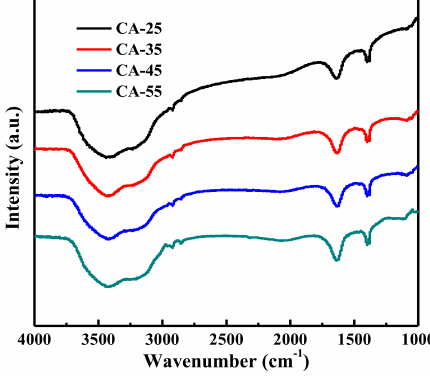
Figure 3. FT-IR spectra of CA-X samples.